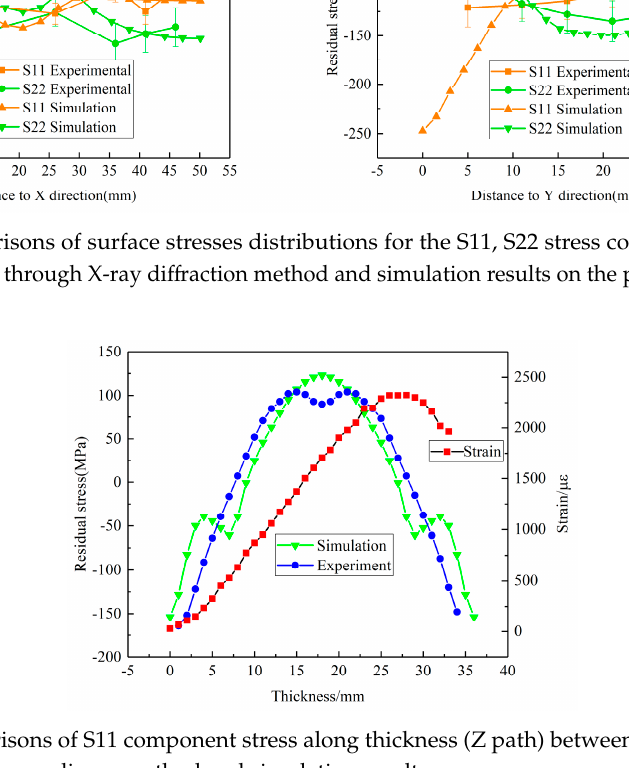
Figure 9. Comparisons of S11 component stress along thickness (Z path) between experimental data obtained by crack-compliance method and simulation results.